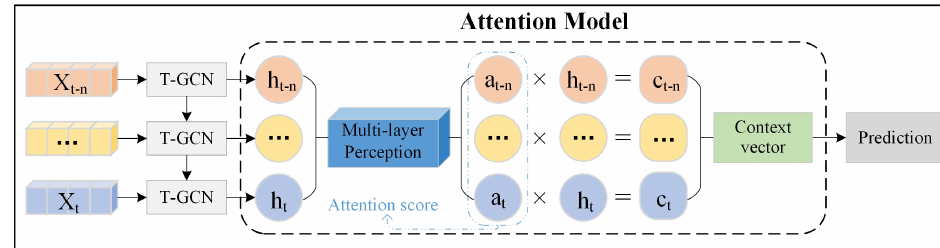
Figure 1. A3T-GCN